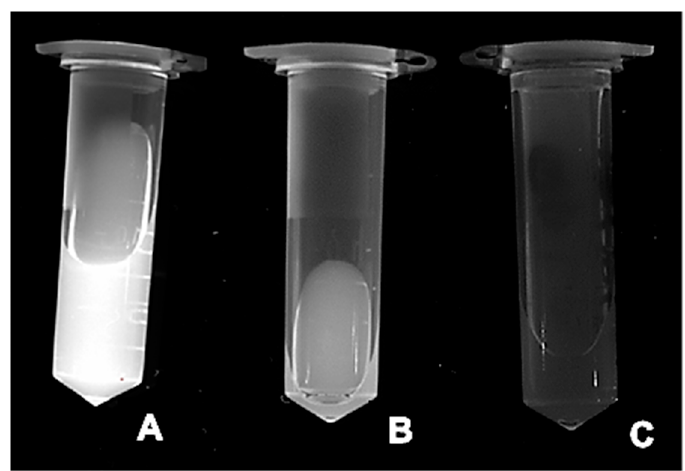
Figure 3. Images of ( A ) QDs, ( B ) QD ‐ liposomes following centrifugation and ( C ) empty liposomes following centrifugation. All images were captured by placing the samples under a UV light.